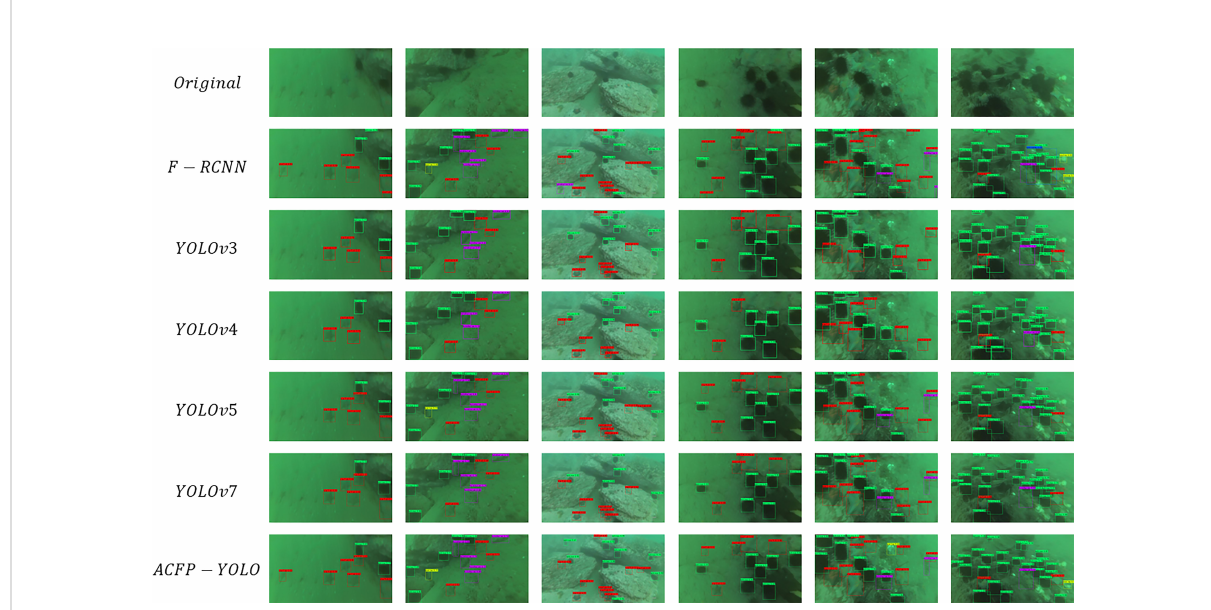
FIGURE 7 The fi rst row Original represents the original image of the dataset, the second row represents the F-RCNN detection image, the third row represents the YOLOv3 detection image, the fourth row represents the YOLOv4 detection image, the fi fth row represents the YOLOv5 detection image, and the sixth row represents the YOLOv7 detection image Figure, the seventh row represents the ACFP-YOLO detection